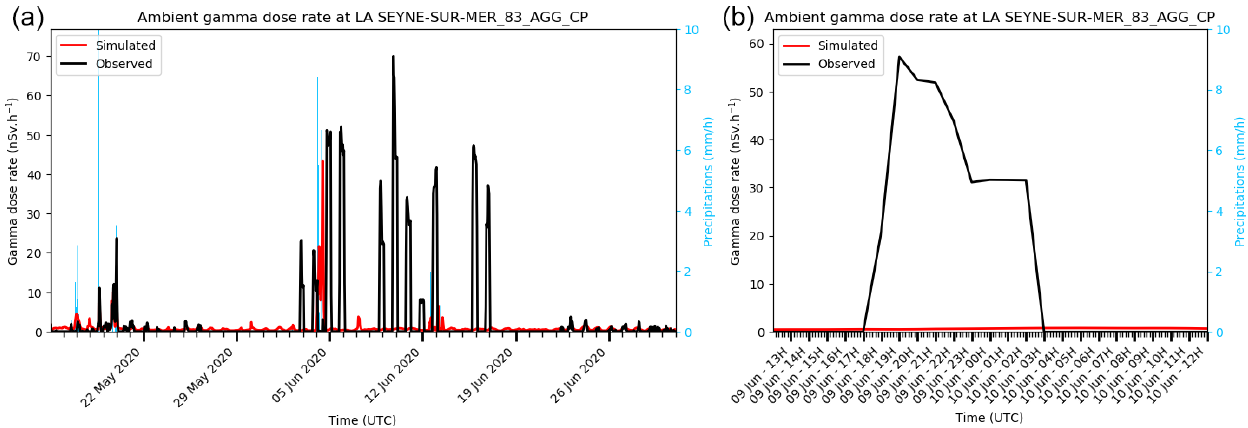
Figure 12. Observed and simulated ambient gamma dose rates at the La-Seyne-sur-Mer station. (a) In May and June 2020. (b) The